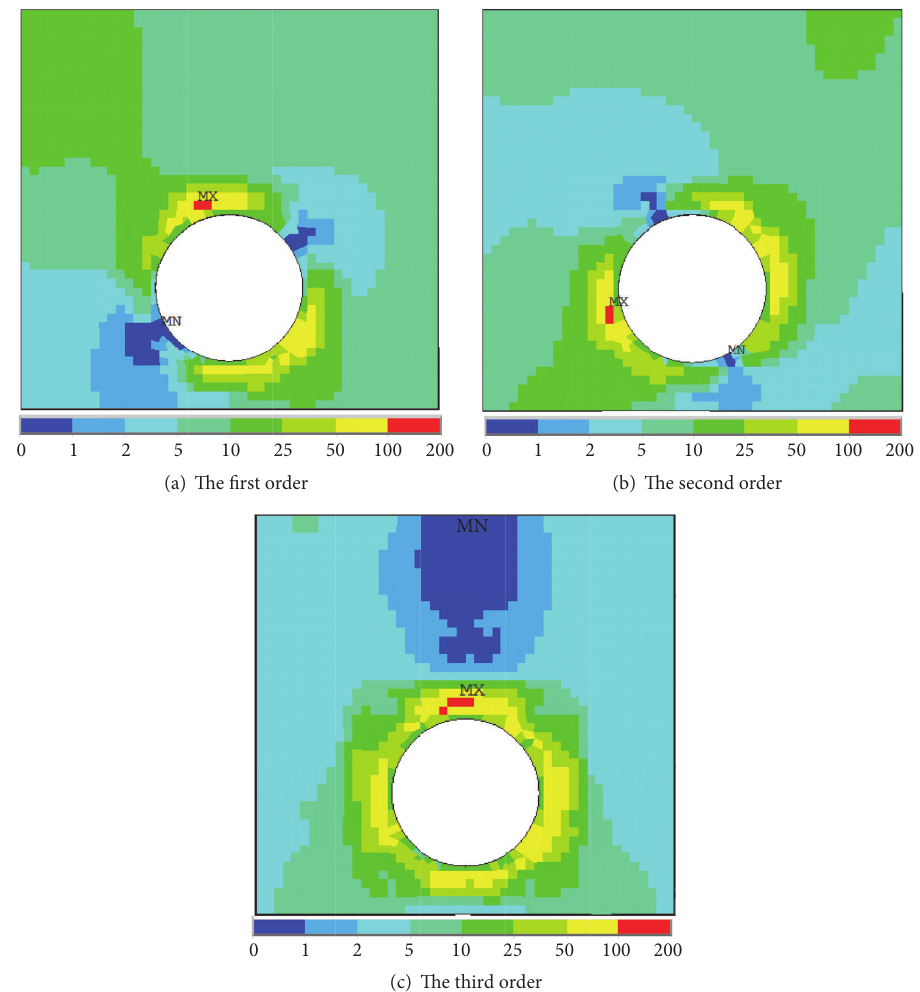
Figure 15: Modal Strain Energy distribution of damping plate.